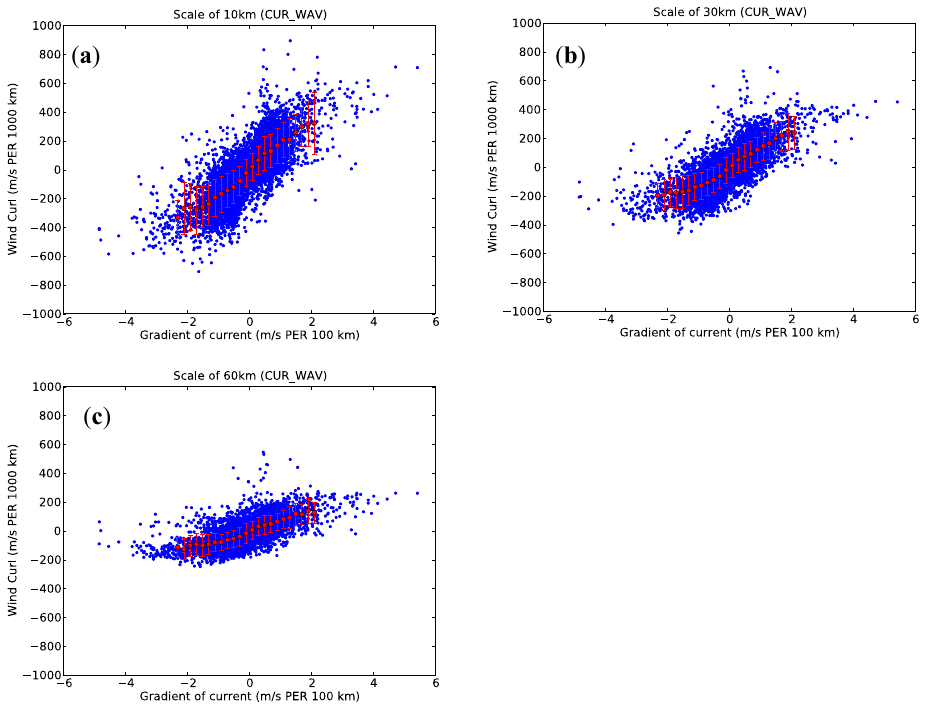
Figure 16. Scatter plots of the wind curl versus the gradient of the current perpendicular to the wind vector from the CUR_WAV experiment. The wind curl is calculated on a scale of ( a ) 10 km, ( b ) 30 km, and ( c ) 60 km, respectively. The error bars represent the standard deviation within each bin.